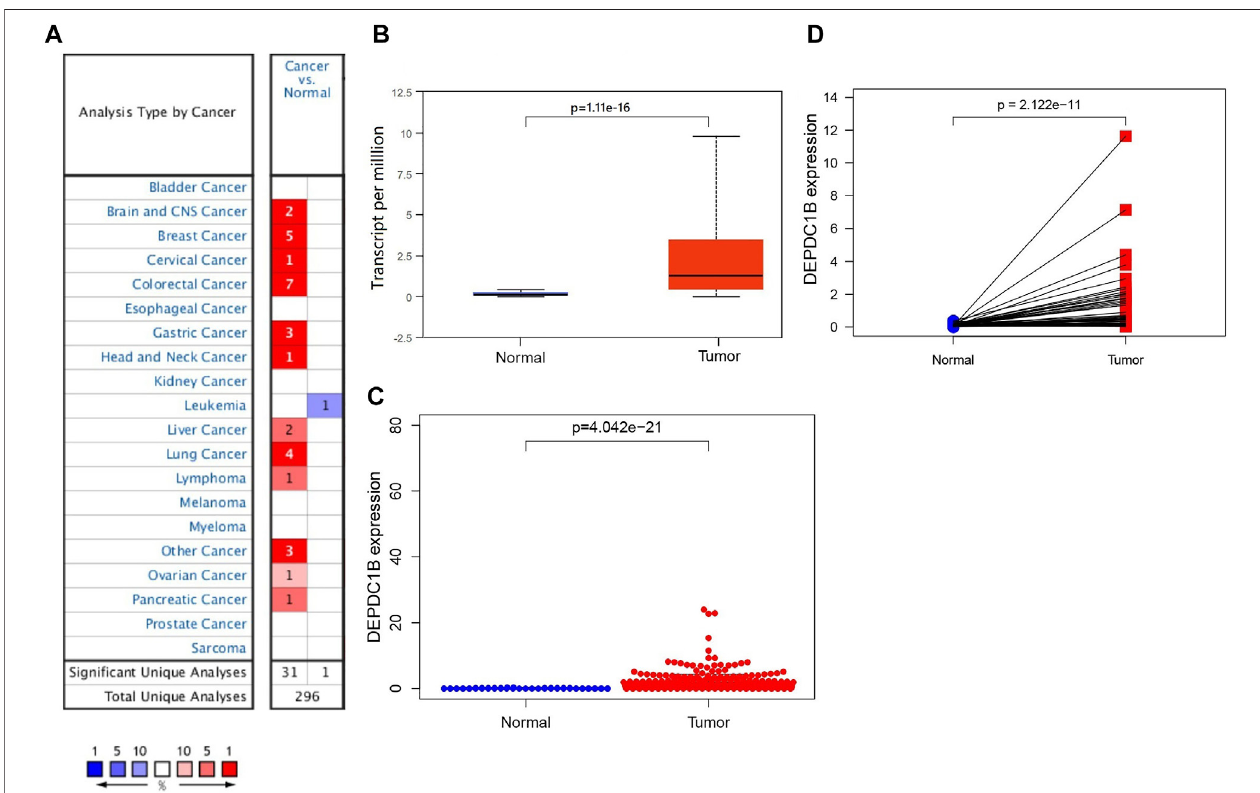
FIGURE1| DEPDC1BexpressioninLIHCtissuesusingonlinedatabases. (A) ExpressionofDEPDC1B(normalcomparedwithcancertissue)wereanalyzedusing Oncomine database. The table shows the number of signi fi cant analyses across the whole Oncomine database (715 datasets and 86.733 samples). DEPDC1B shows high/low expression ratio of 31/1 from 32 analyses. The cell color is determined by the best gene rank percentile for the analyses within the cell. The number in each cell represents the number of analyses that meet the threshold within those analysis and cancer types. The gene rank was analyzed by percentile of target gene in the topofallgenesmeasuredineachresearch. (B) UALCANdatabase.Thenumberofpatientsinnormalandprimarytumorgroupswas50and371,respectively. p (cid:1) 1.11e- 16. (C) TCGA database using R script. Normal ( n (cid:1) 50), Tumor ( n (cid:1) 374). p (cid:1) 4.042e-21. (D) DEPDC1B expression in a paired comparison of LIHC and their adjacent tissues. Data were extracted from the TCGA database. n (cid:1) 50. p (cid:1)